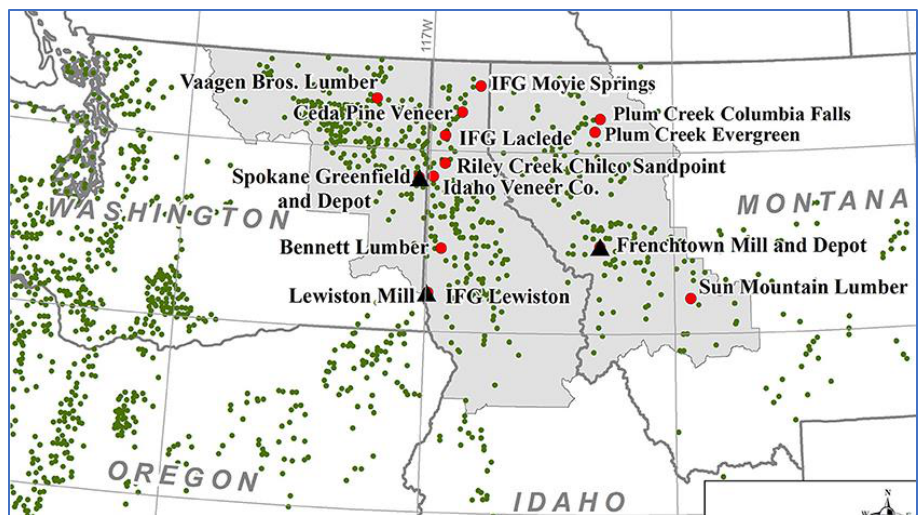
Figure 2. Proposed forest depot configuration in northern WA, ID and MT. Included are processing facilities (black triangles), forest depots (red circles), and biomass sources (green dots). Source: Martinkus et al., 2018.